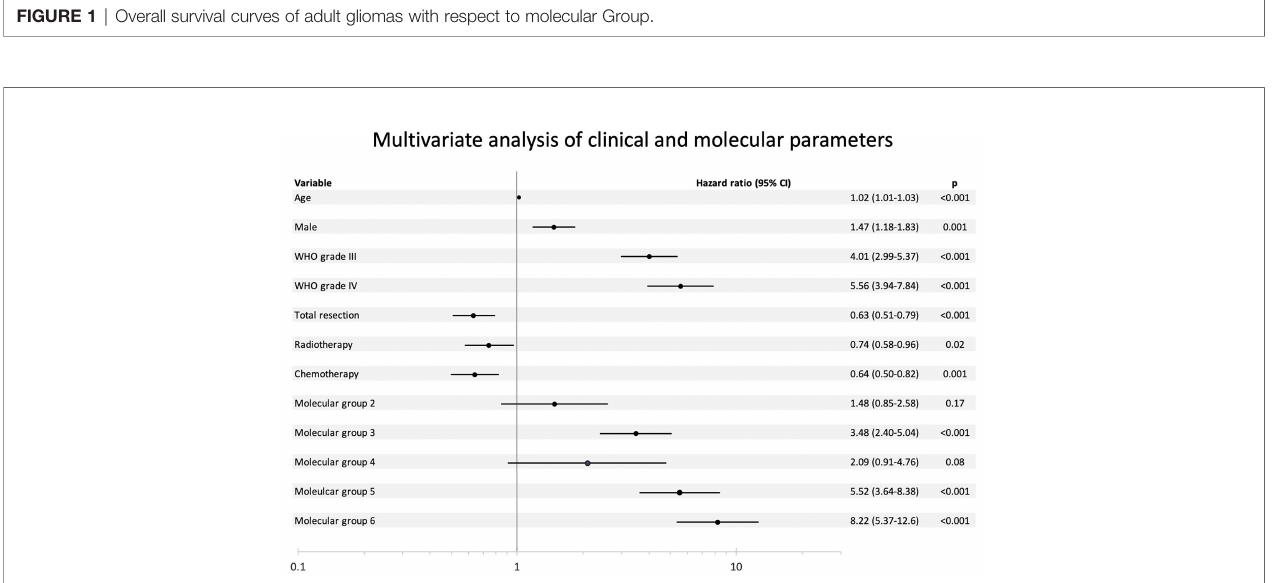
FIGURE 1 | Overall survival curves of adult gliomas with respect to molecular Group.